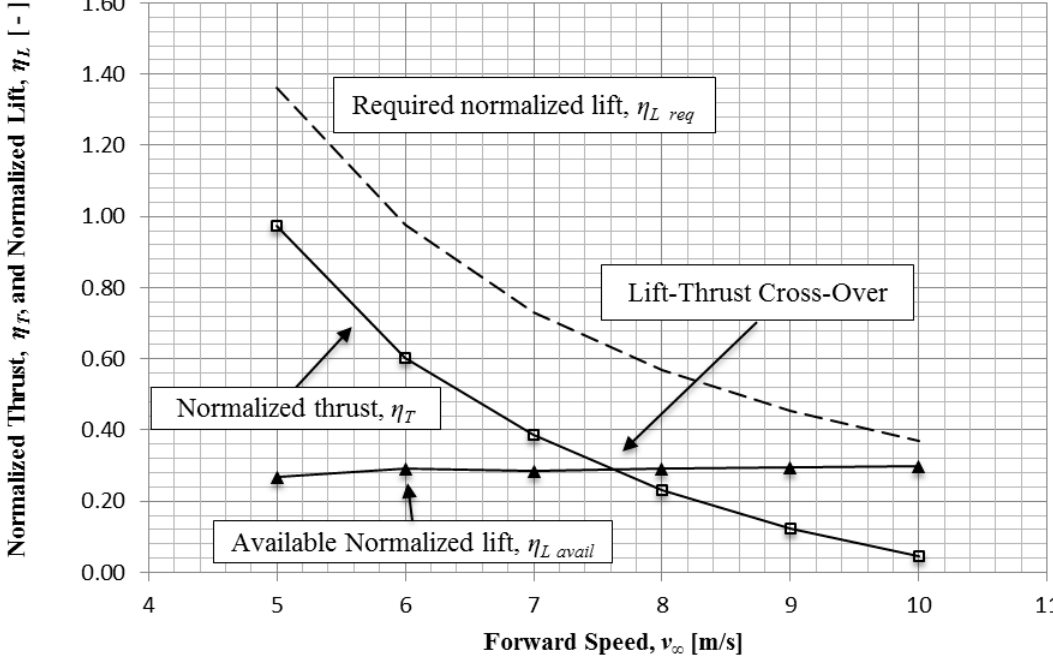
Figure 7. The normalized thrust, the available, and the required normalized lift for 5 m/s ≤ v ∞ ≤ 10 m/s. The dashed curve in Figure 7 represents the required normalized lift, η L req , necessary to achieve flight, which is higher than η L avail , throughout the velocity interval of 5 m/s ≤ v ∞ ≤ 10 m/s. Hence, the bird and the analogous protobird are not capable of lift-off in this range of forward speeds.